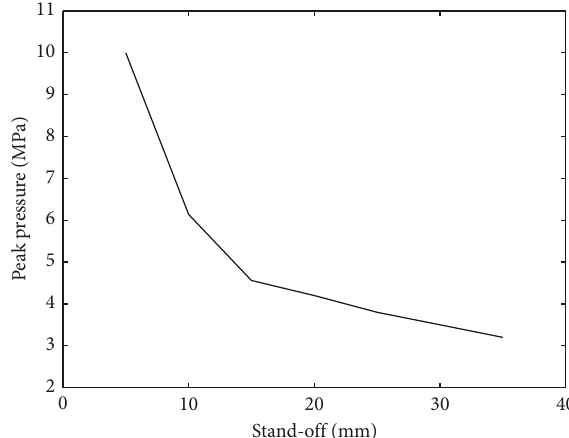
Figure 15: Peak pressure loading versus stand-off.